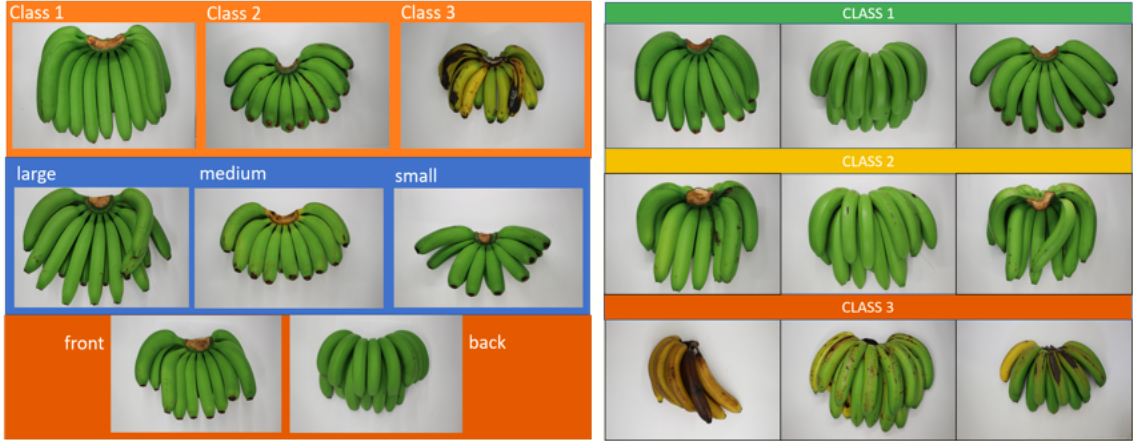
Figure 7. Different banana classifications obtained by the banana grading system.